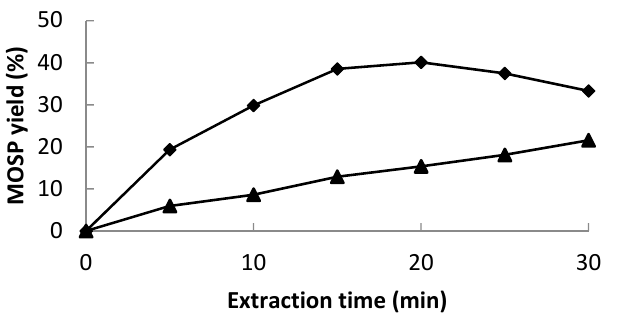
Figure 3. MOSP yield (%) during ultrasound-assisted extraction ( ) and conventional extraction ( ▲ ).